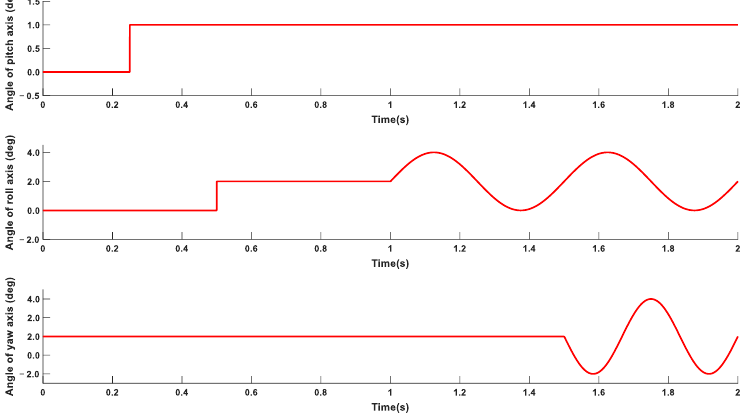
Figure 6. Reference input–angle signal of each axis.